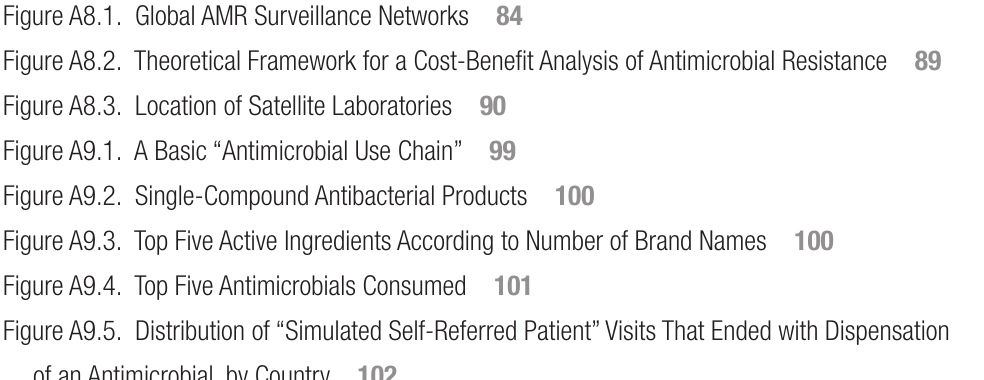
Figure A8.1. Global AMR Surveillance Networks Figure A8.2. Theoretical Framework for a Cost-Benefit Analysis of Antimicrobial Resistance Figure A8.3. Location of Satellite Laboratories Figure A9.1. A Basic “Antimicrobial Use Chain” Figure A9.2. Single-Compound Antibacterial Products Figure A9.3. Top Five Active Ingredients According to Number of Brand Names Figure A9.4. Top Five Antimicrobials Consumed Figure A9.5. Distribution of “Simulated Self-Referred Patient” Visits That Ended with Dispensation of an Antimicrobial, by